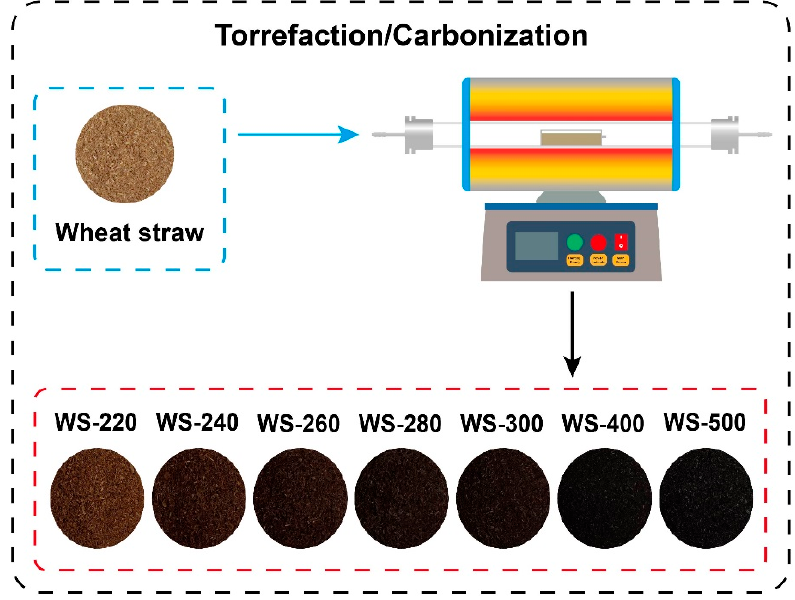
Figure 1. Schematic diagram of torrefaction/carbonization of raw WS.